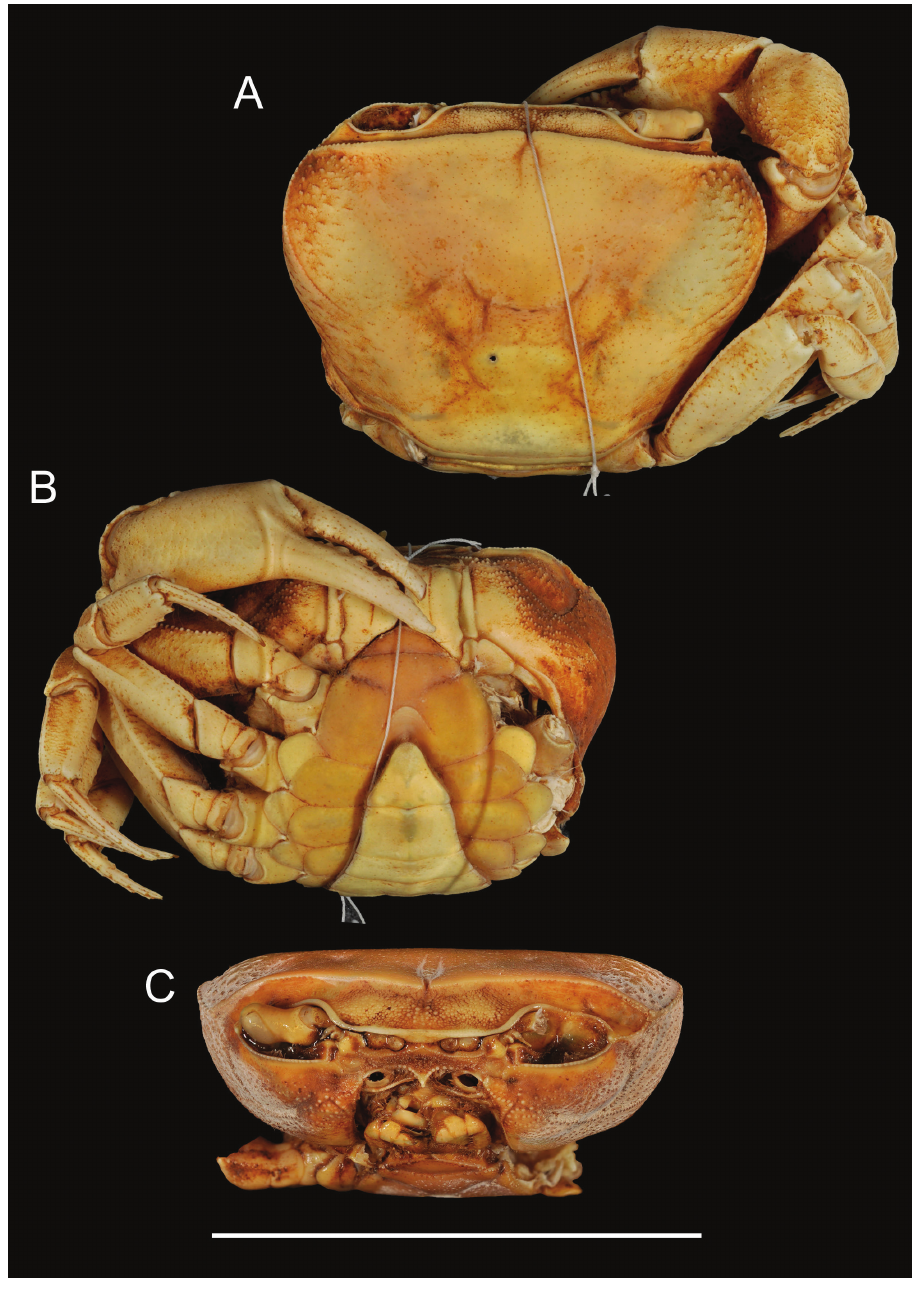
Figure 4. Potamonautes sidneyi (Rathbun, 1904). Male holotype CWW 47 mm (Yale Peabody Museum catalogue number 1191) A dorsal view B ventral view, and C cephalothorax, frontal aspect. Scale bar: 50 mm. Photos: Eric